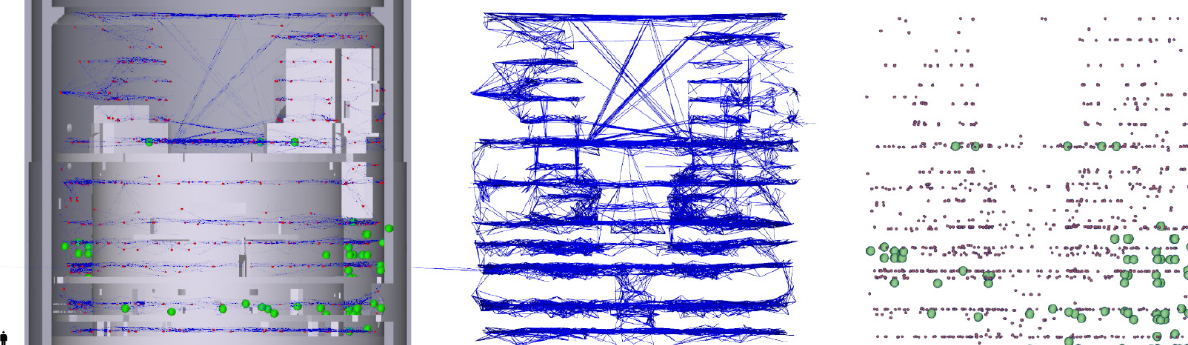
Figure 1: front view of the kilo-stations network of the TLS dataset of a cylindrical industrial building. On the left, concrete walls and floors of the buildings, with a human silhouette for scale. The sights of all targets as seen from TLS stations are traced in blue; TLS stations (one thousand) are the reds dots and control points are the larger green